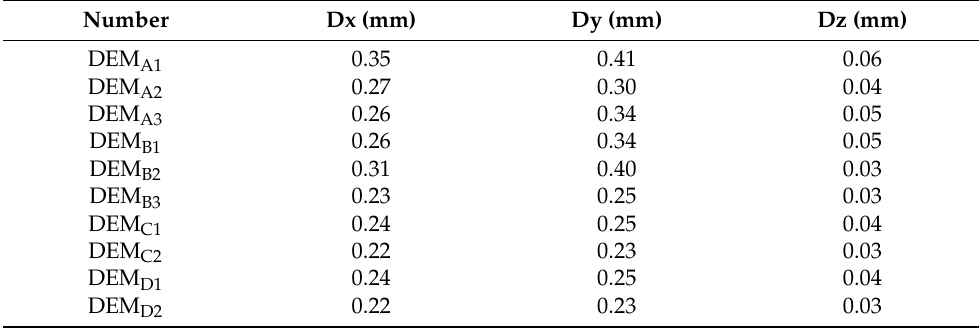
Table 3. RMSE 3D of the DEM generation for the test